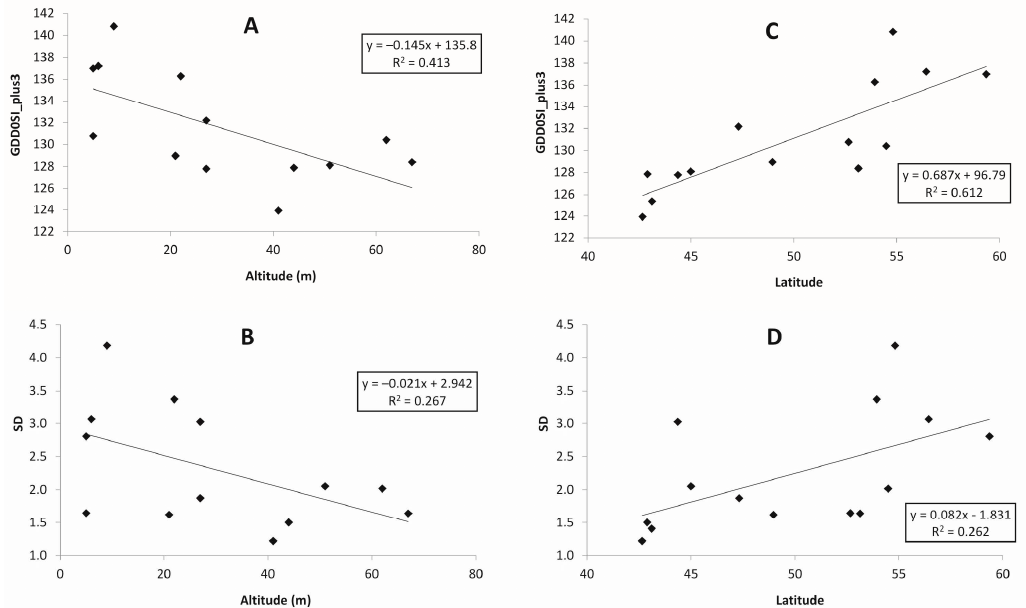
Figure 6. Dependence of Sensitivity Index for growing degree days with 15 °C threshold (GDD15SI) and its standard deviation (SD) for a GDD15 + 3 scenario on altitude and latitude for continental locations in the Russian Far East for the period 1966–2017: ( A , B ) altitude (m), ( C , D ) latitude.